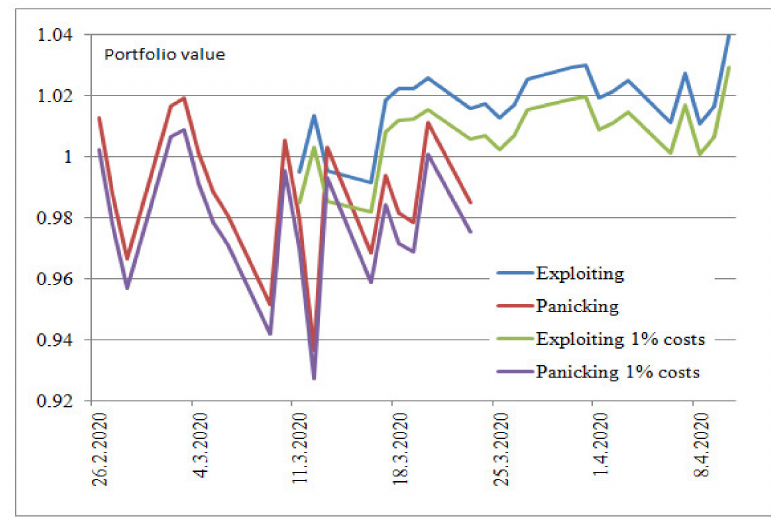
Figure 5. Values of simulated